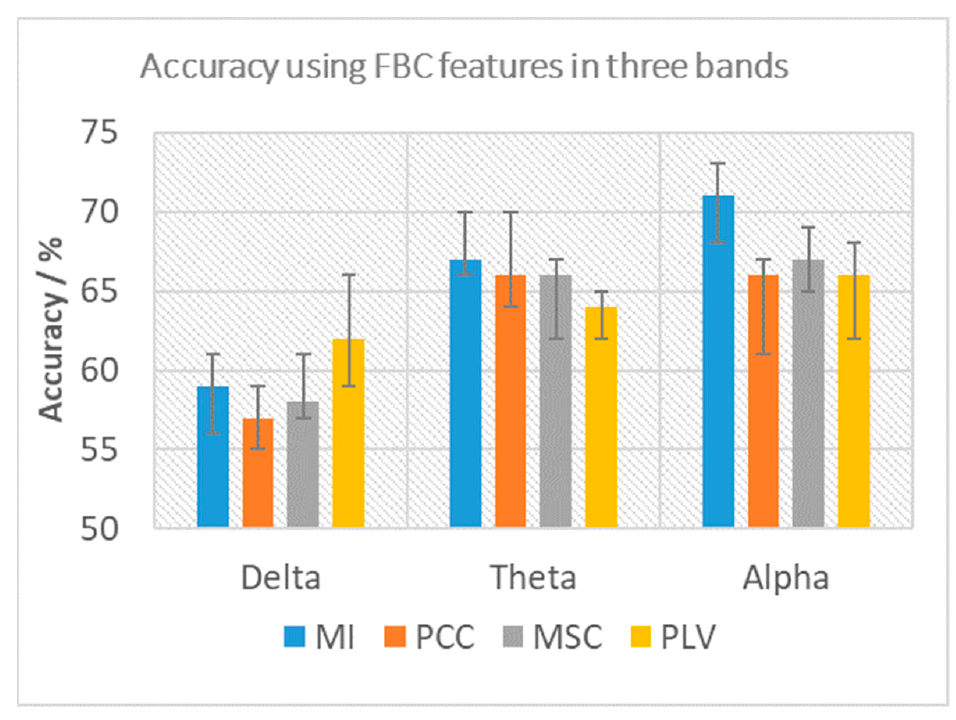
Figure 4. Comparison of four FBC estimations (MI, PCC, MSC and PLV) in terms of the average of the Top 10 classification accuracies along with maximum and minimum value. Table 2. SVM classification accuracy of 0-back vs. 2-back using different features.